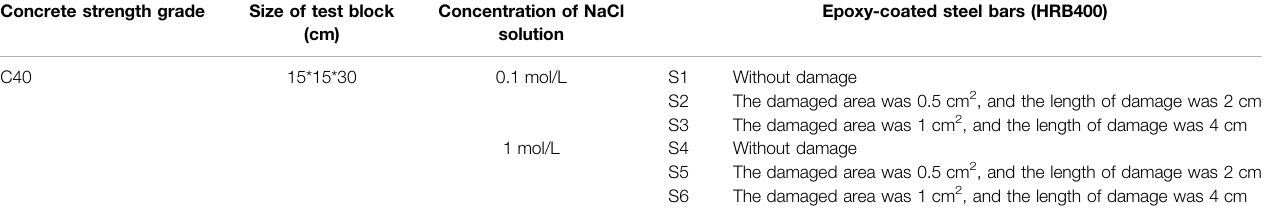
TABLE 1 | Parameters of test block. Concrete strength grade